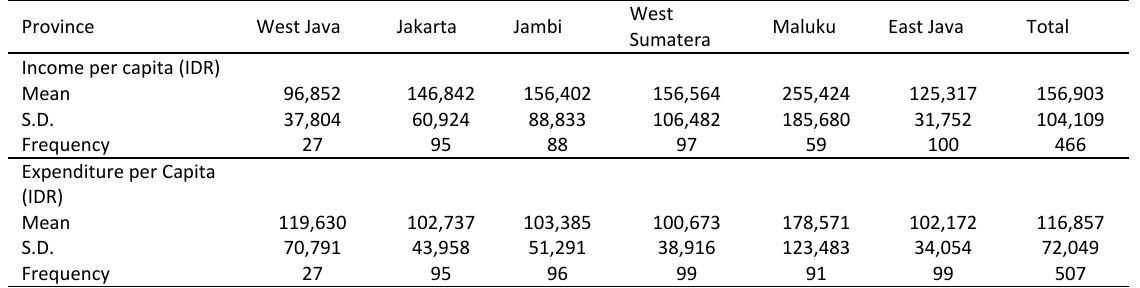
Table 1: Summary statistics of income and expenditure per capita Province West Java Jakarta